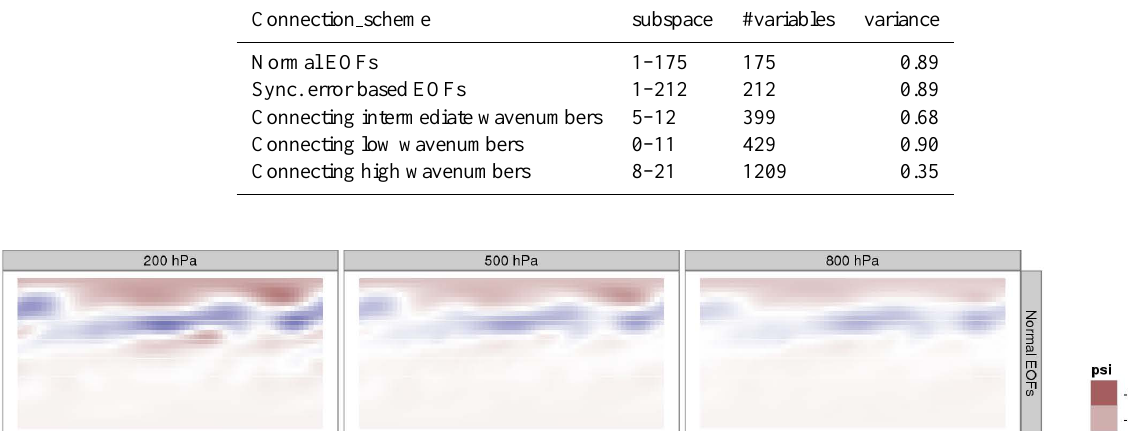
Table 1. Minimum subset of the model state space that needs to be connected for CS in the third experiment ( T n = 0 . 5).